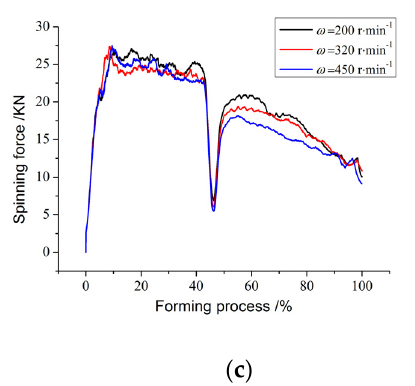
Figure 8. The change of the rotational force when f is the same: ( a ) f = 0.6 mm/r; and ( b ) f = 1.0 mm/r; ( c ) f = 1.4 mm/r.